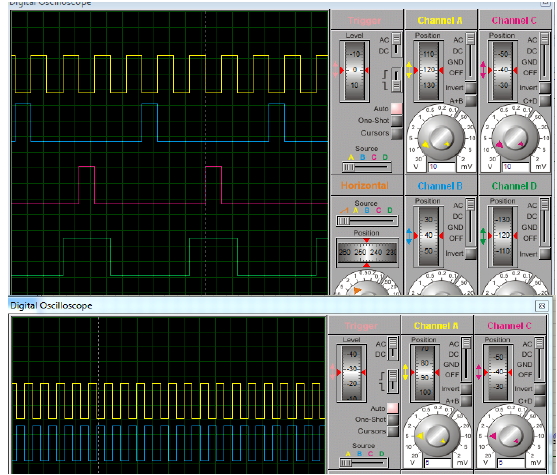
Figure 19 . Output switching Pulses for 7-Level Inverter